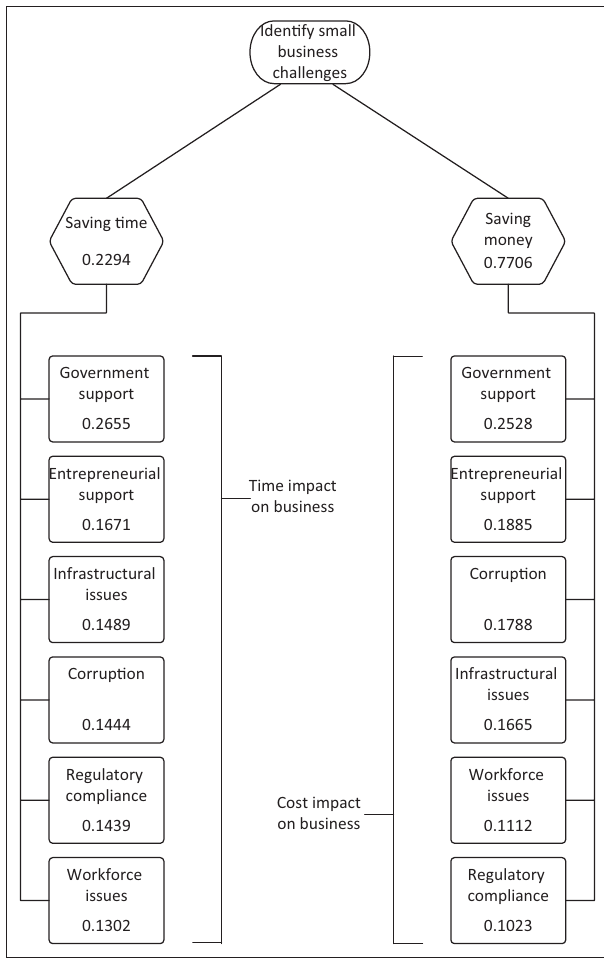
FIGURE 9: Relative impact of small-business